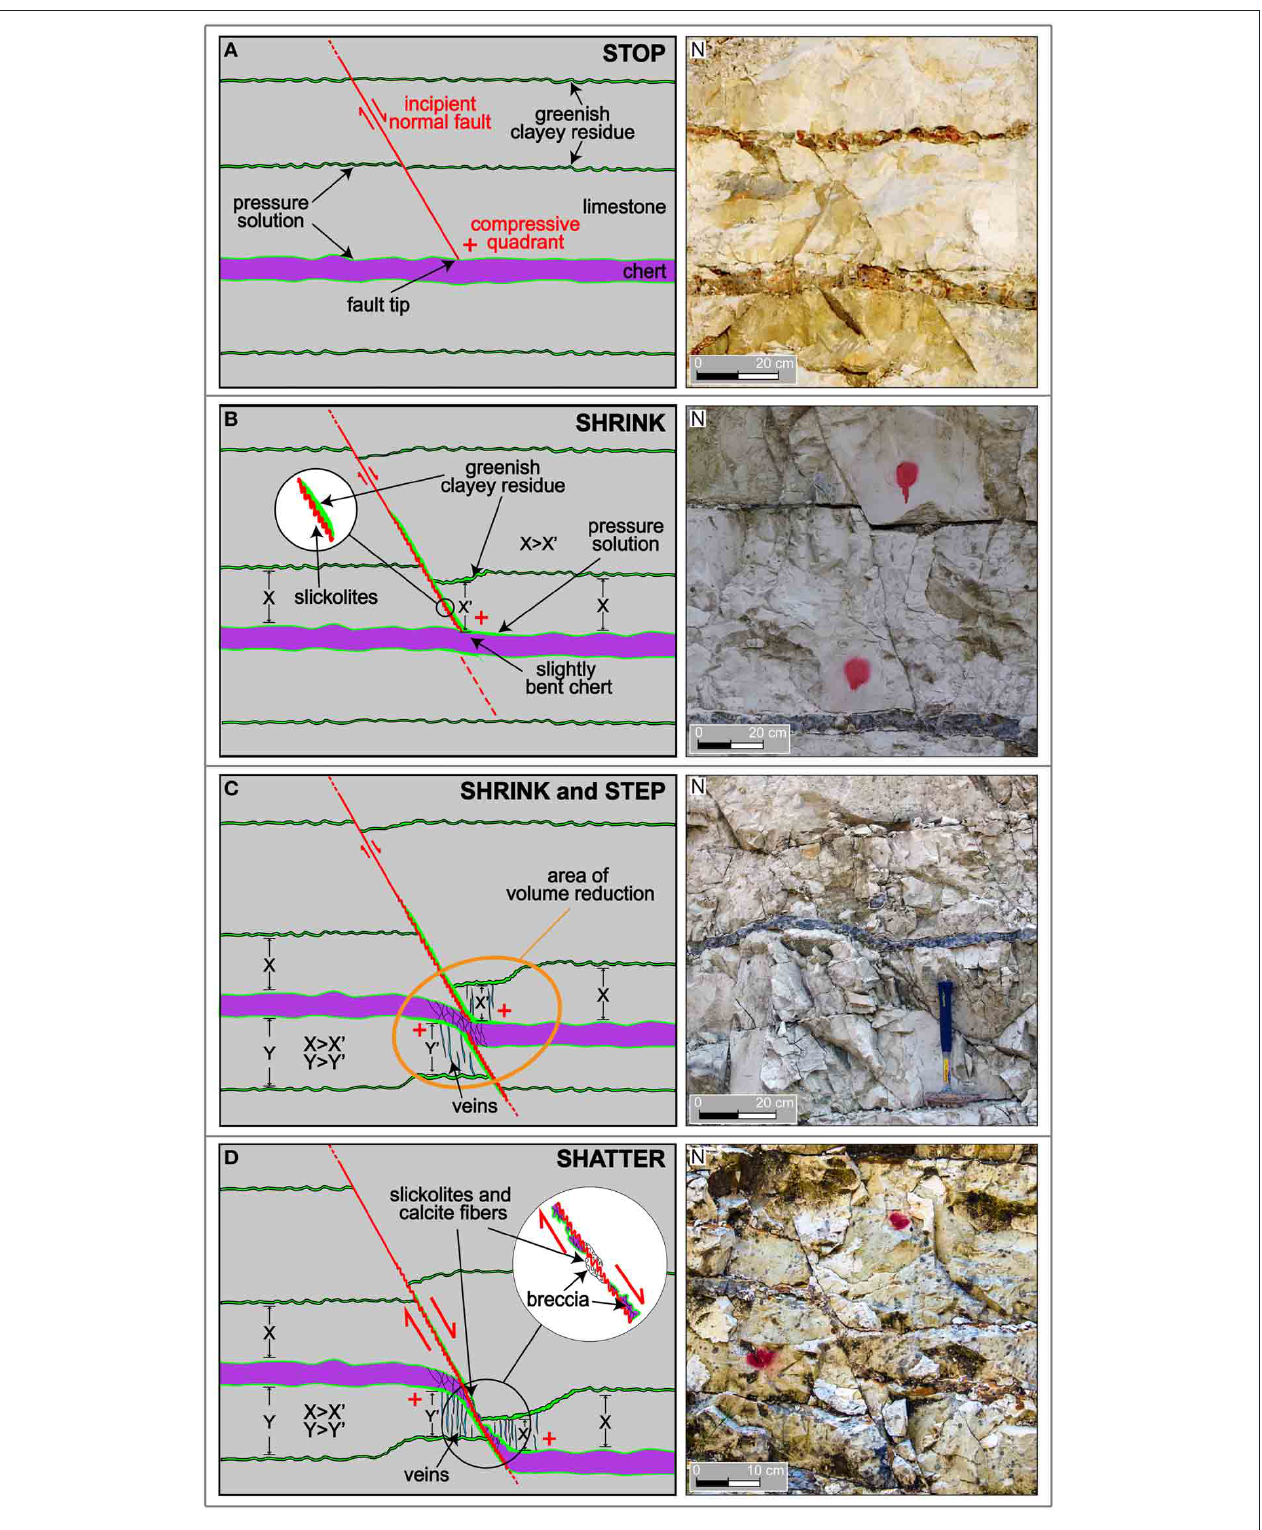
FIGURE 14 | Conceptual model of fault post-nucleation growth in four steps. (A) Stop: the faults stopped at the competent chert beds. (B) Shrink: faulting produced shrinkage (pressure solution) of carbonate beds at the fault compressive terminations. (C) Shrink and Step: while shrinkage by pressure solution continued, the faults stepped laterally at the competent chert beds. (D) Shatter: the chert beds were shattered along the fault surfaces.